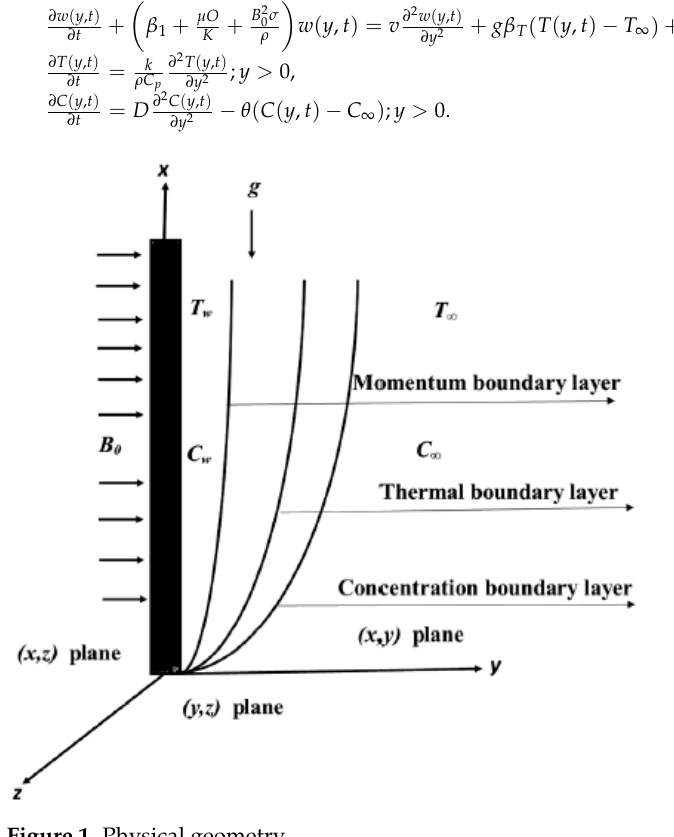
Figure 1. Physical